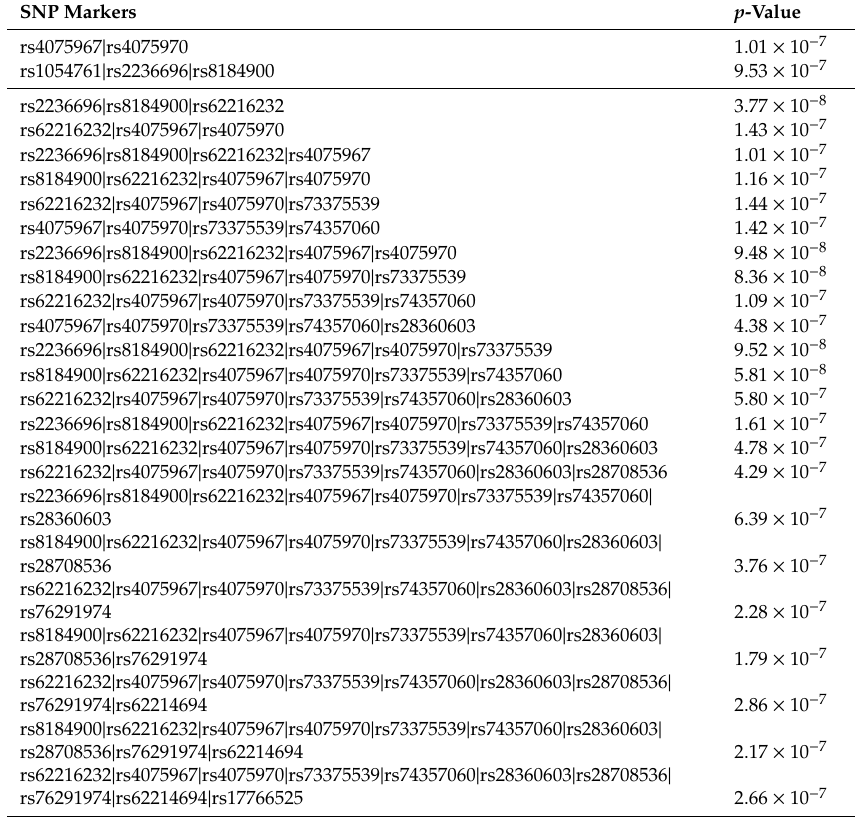
Table 4. Association analyses of sliding windows of 2–10 single nucleotide polymorphisms each, using chi-square statistics within PLINK software (only p -values < 10 − 6 are